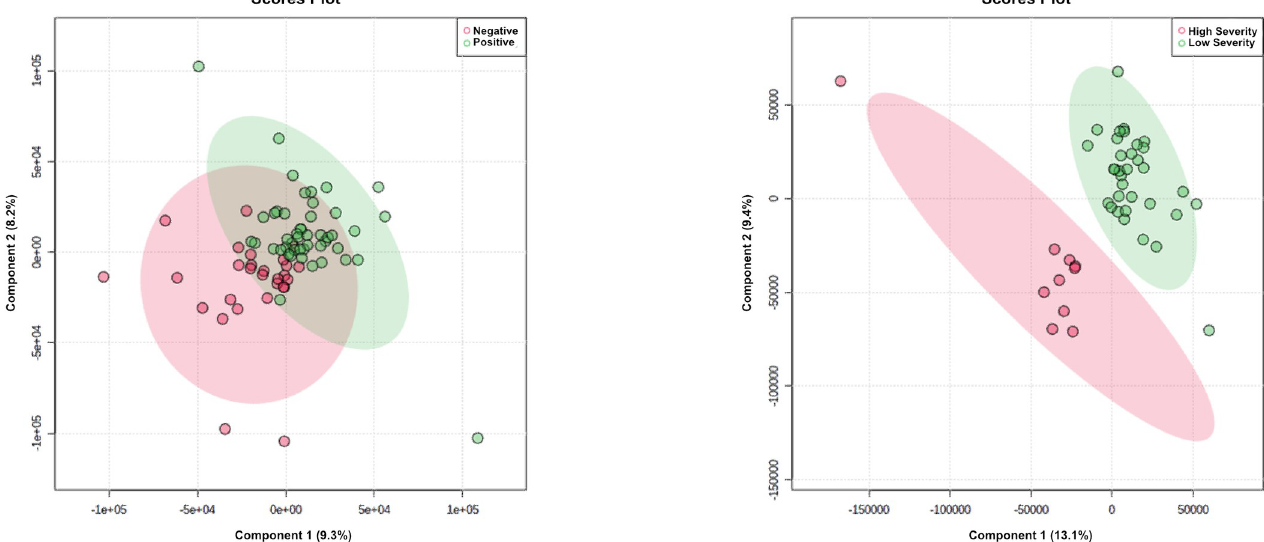
Fig 2. Saliva metabolomics analysis for COVID-19 diagnosis and prognosis via LC-MS in positive mode, showing: A PLS-DA plot for 75 participants and 324 features, COVID-19 positive / negative. B PLS-DA plot for 44 participants and 324 features, high severity / low severity. C LOOCV confusion matrix, COVID- 19 positive / negative. D LOOCV confusion matrix, high severity / low